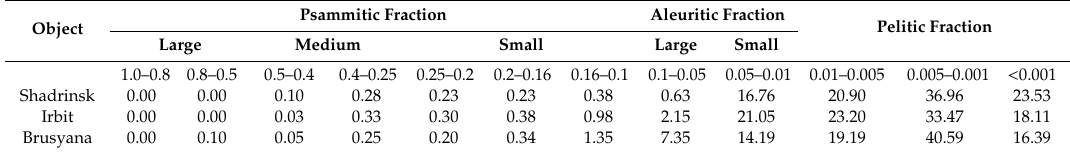
Table 1. Results of grain size